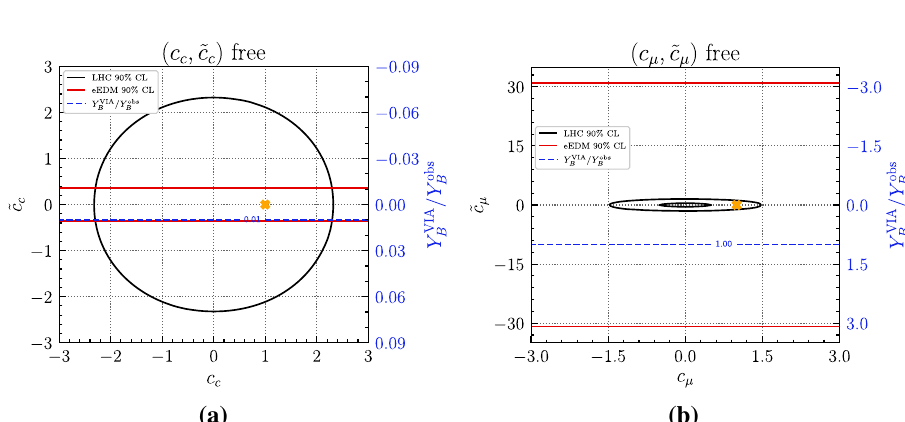
that is allowed by the eEDM constraint, only Y VIA 0 . 01 can be